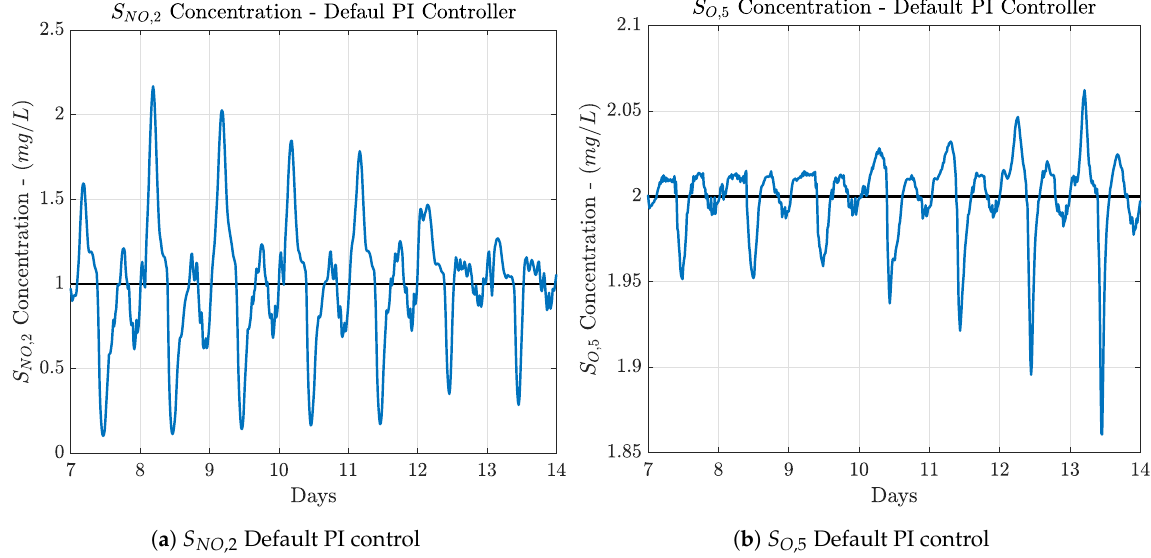
Figure 4. Control performance when the default PI controllers are adopted. Notice that the worst performance is offered by the S NO ,2 default PI